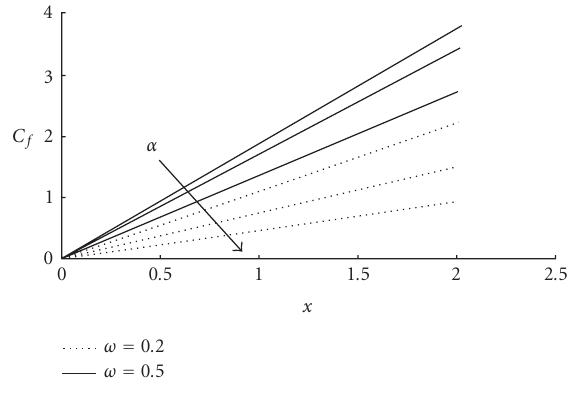
Figure 5.4. E ff ect of Alfven velocity α on friction coe ffi cient, where α = 0 . 0,0 . 2,0 .